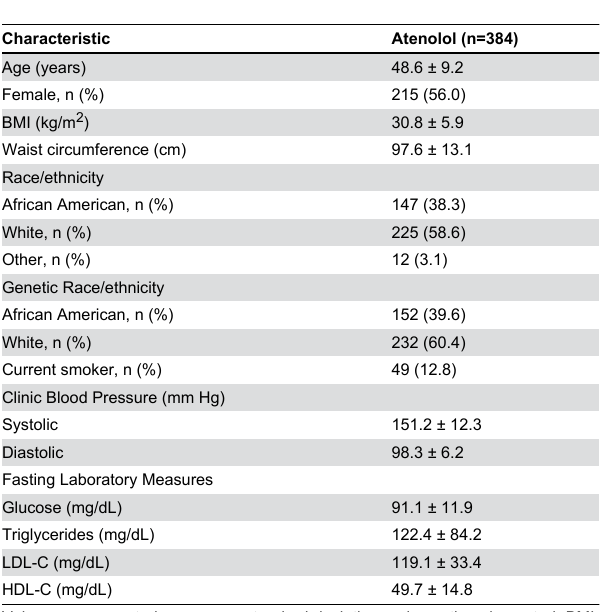
Table 1. Baseline characteristics and demographics of PEAR study participants treated with atenolol